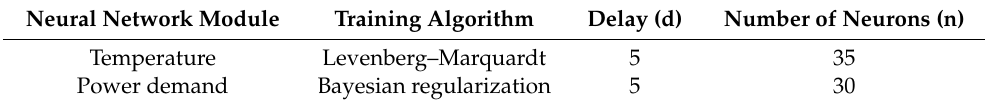
Table 1. Neural network architecture parameters.